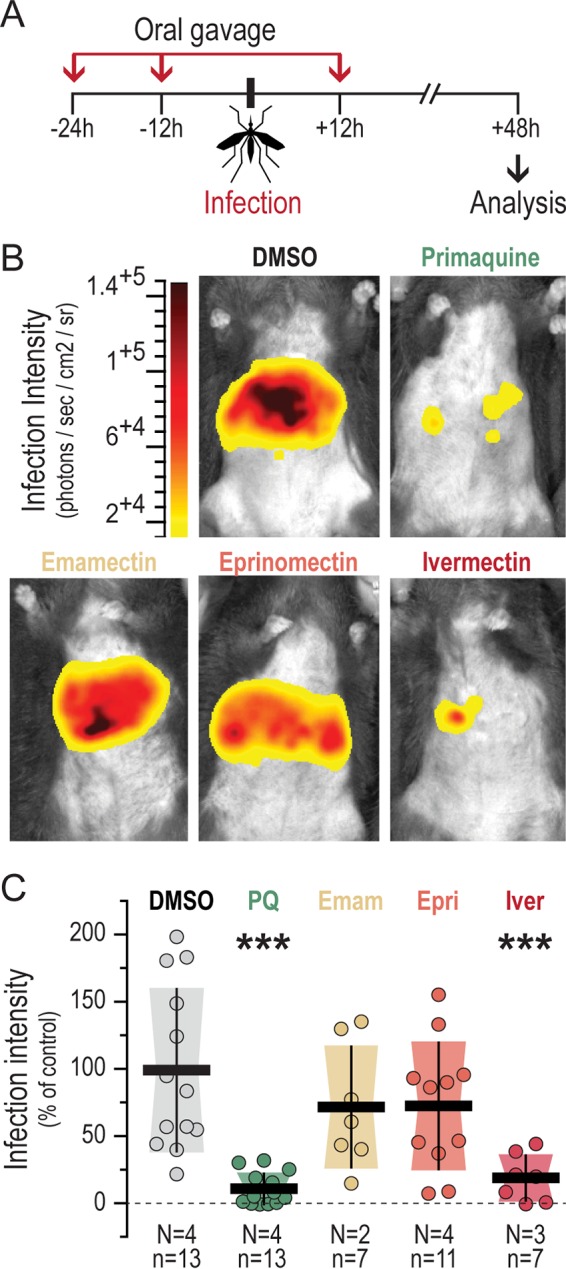
Ivermectin decreases liver infection in vivo. (A) Schematic illustration of the in vivo experimental setup. The arrows indicate when each avermectin was orally administered at 10 mg/kg. Vehicle- or primaquine (10 mg/kg)-treated mice were used as controls. P. berghei spz were delivered by the bites of 5 to 7 mosquitoes. (B) Representative bioluminescence images of mouse livers at 48 hpi. (C) Liver parasite infection loads in mice treated with the various compounds, relative to those in DMSO-treated controls. Dots represent the radiance intensity of individual liver areas relative to the average radiance of all DMSO-treated mice. The total number of mice (n) in each data set and the number of independent biological replicate experiments (N) performed are indicated. The statistical significance of differences from the DMSO-treated mice was calculated by employing the nonparametric Mann-Whitney test. P values are indicated above each data set (***, P < 0.001). Horizontal dark lines indicate the relative mean liver parasite infection load, whereas the vertical bars and shaded area represent the standard deviation of the mean. PQ, primaquine; Emam, emamectin; Epri, eprinomectin; Iver, ivermectin.